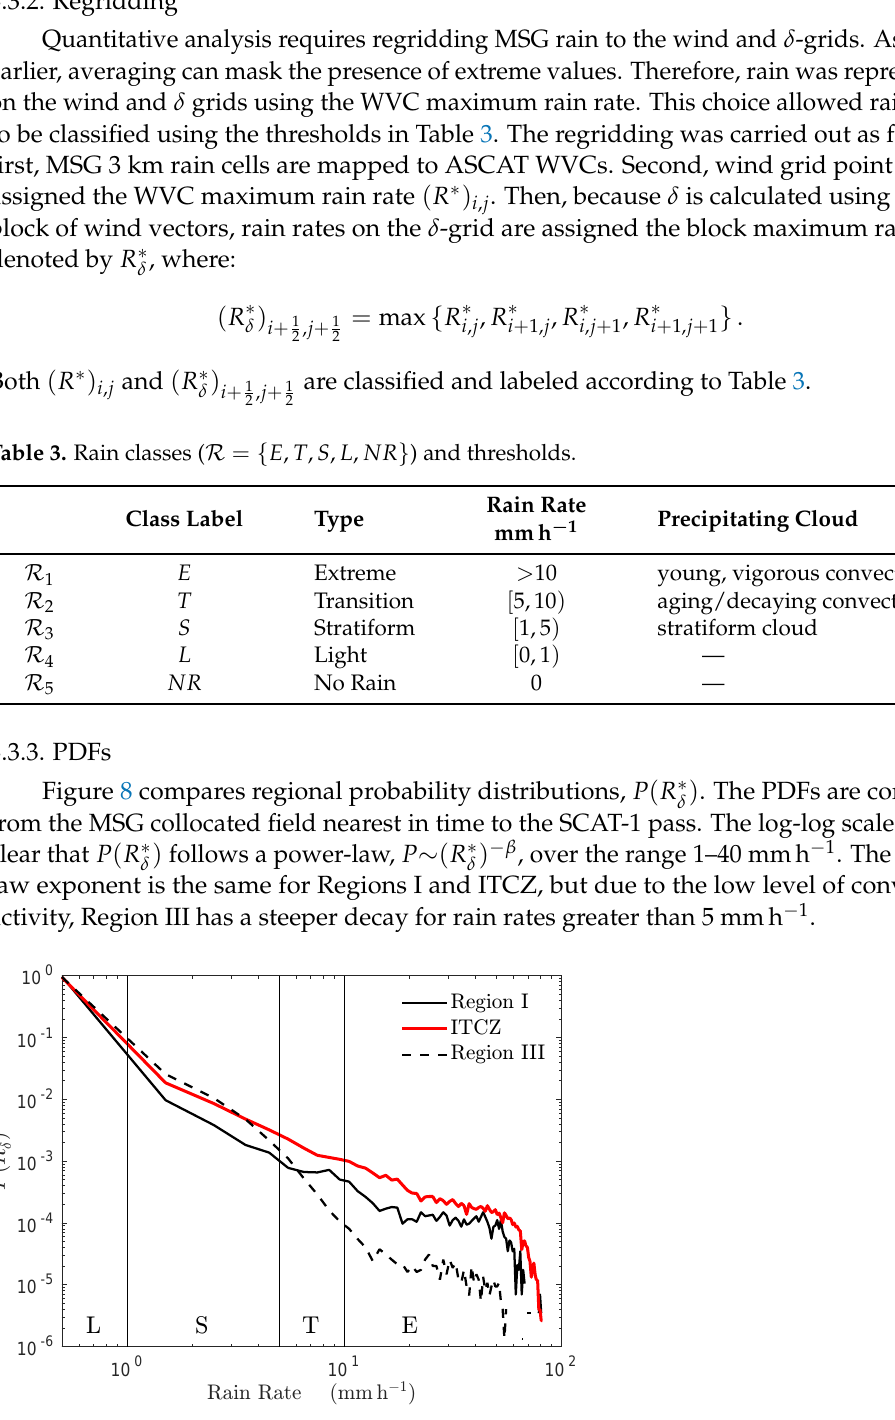
Figure 8. Probability distribution of rain, P ( R ∗ classes are shown along bottom of